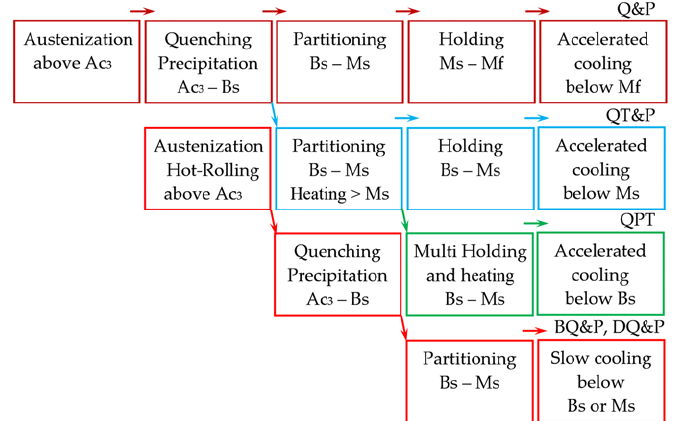
Figure 10. Diagrams of TMCP: quenching and partitioning (Q&P); quenching-tempering and partitioning (QT&P); quenching-partitioning-tempering (QPT); non-isothermal direct quenching